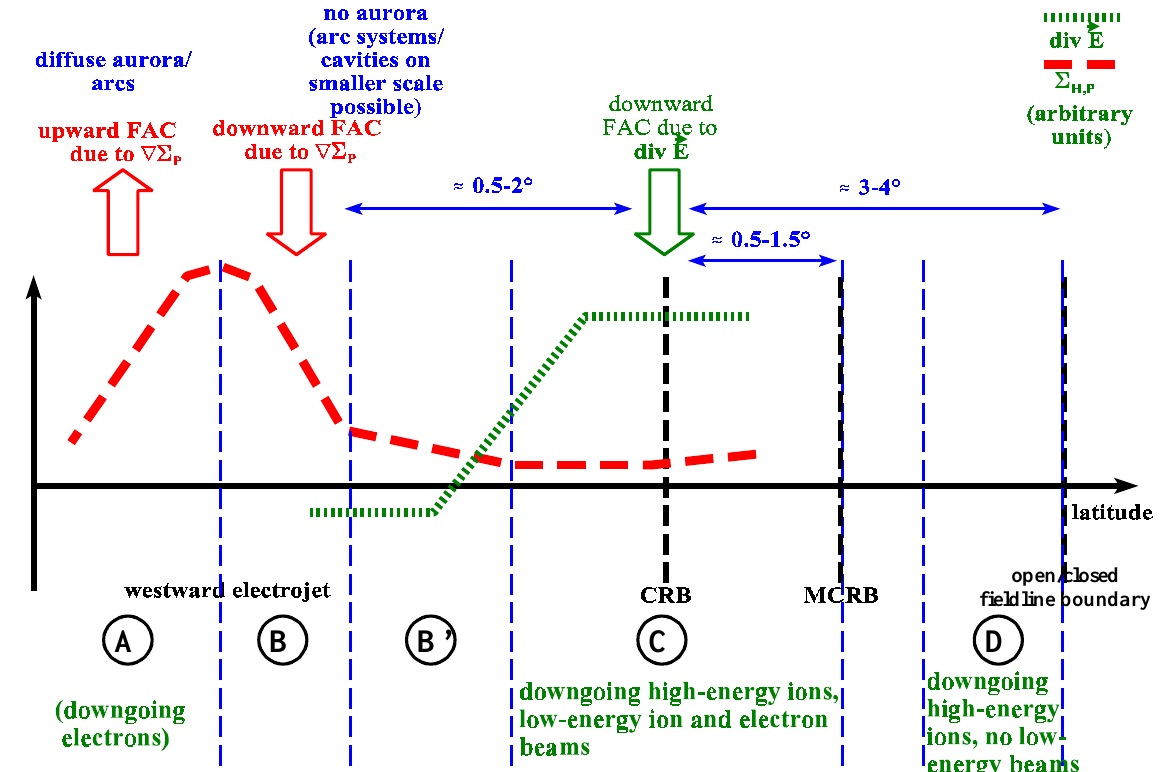
Fig. 12. Summary sketch of the observations and analysis results for the ionospheric electrodynamic, auroral, and particle signatures along the early morning side shear flow